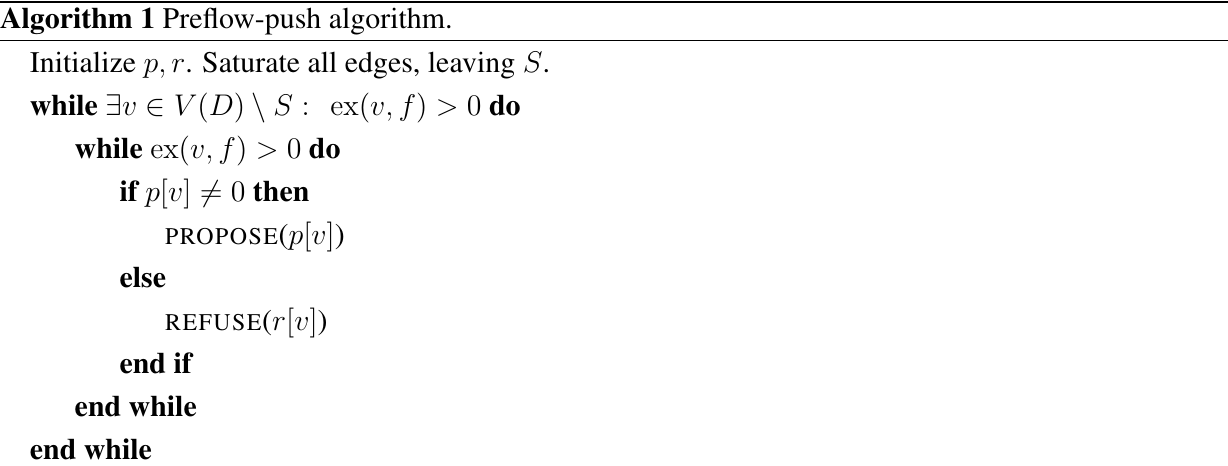
Algorithm 1 Preflow-push algorithm.